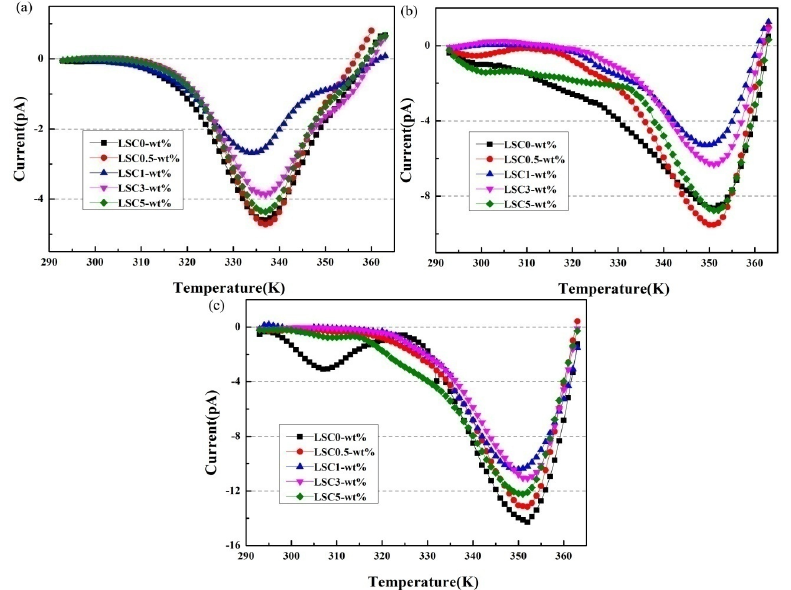
Figure 10. Thermal stimulation current of LDPE when different semiconductive layers are used as electrodes, the applied electric field was: ( a ) 10 kV/mm, ( b ) 30 kV/mm, ( c ) 40 kV/mm at room temperature.